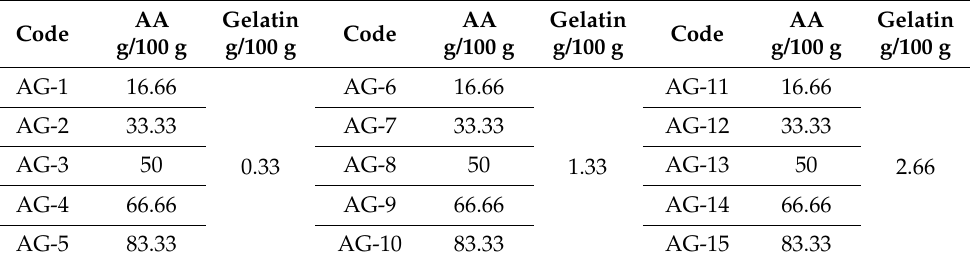
Table 1. Ingredients of HP- β -CD-g-poly(AA)/gelatin semi-IPN hydrogel